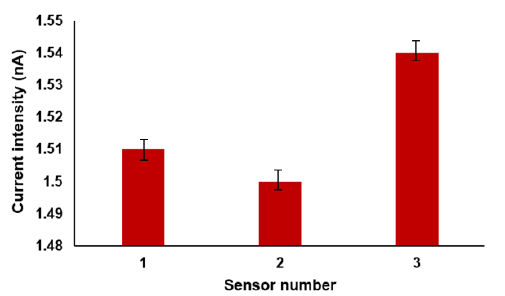
Figure 8. Reproducibility of the TPP/AuNPs-S-Gr sensor.